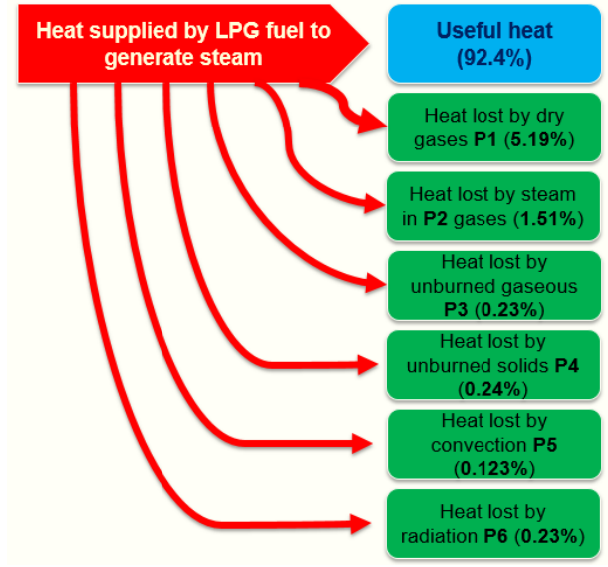
Figure 7. Sankey diagram: distribution of losses to generate steam.